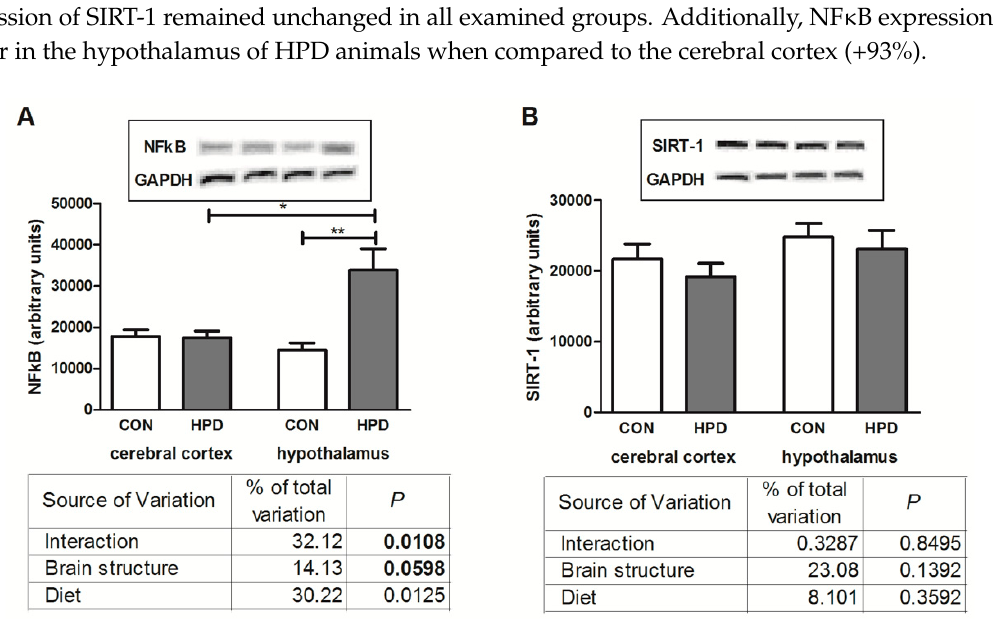
Figure 6. Effect of 8-week HPD on NF κ B ( A ) and SIRT-1 ( B ) in rat cerebral cortex and hypothalamus. Values are means ± SEMs. Differences statistically significant at: * p < 0.05, ** p < 0.005. CON, standard diet; GAPDH, glyceraldehyde 3-phosphate dehydrogenase; HPD, high protein diet; NF κ B, nuclear factor κ B; SIRT-1, sirtuin 1.